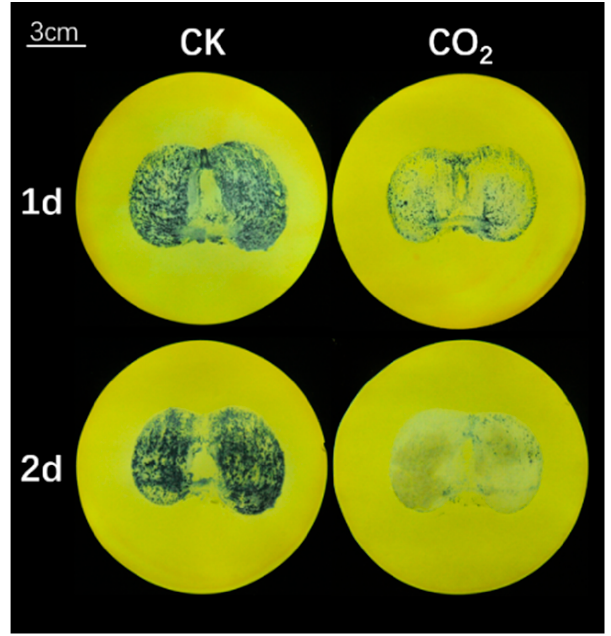
Figure 2. Changes in fruit-soluble tannins in response to high CO 2 treatment. Fruit was treated with high CO 2 (CO 2 ) or air (CK) for 1 d at 20 °C and then cut and printed onto FeCl 2 -soaked filter paper to reveal soluble tannins, revealed by the intensity of the black color.